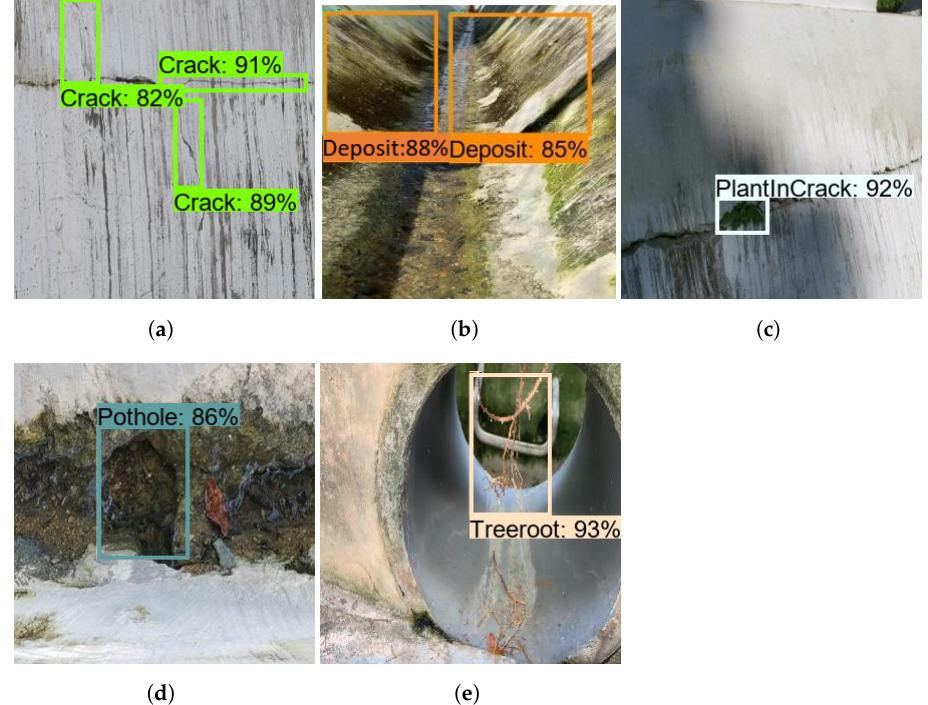
Figure 19. Real-time defect detection. ( a ) Crack; ( b ) Plant in crack; ( c ) Tree root; ( d ) Plant in crack;